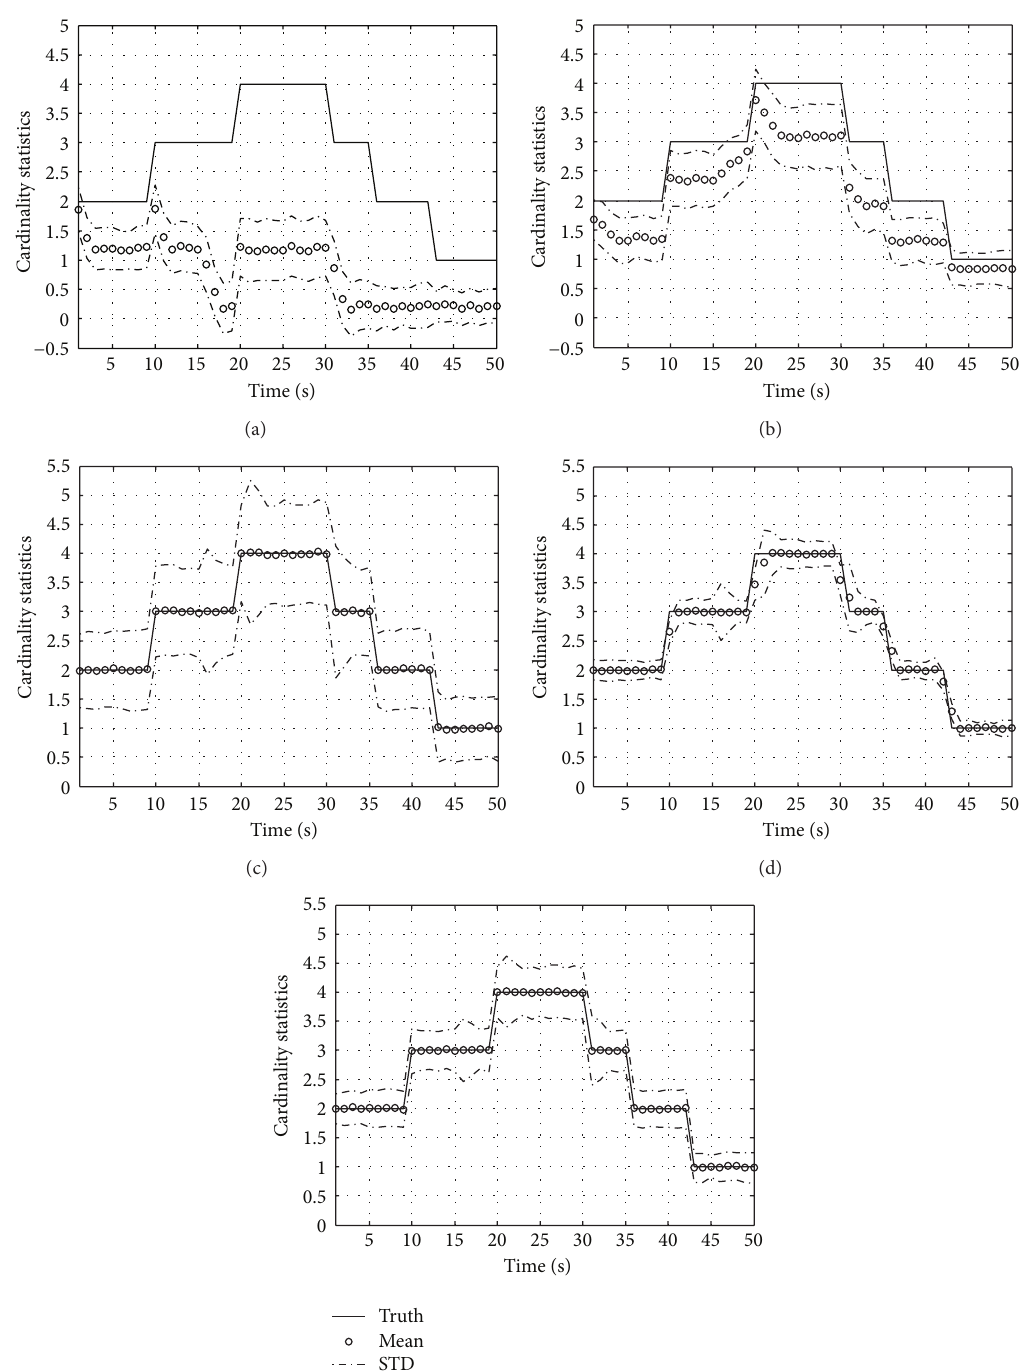
Figure 2: The 500 MC run averages of cardinality statistics versus time for the (a) CV model SMC-CBMeMBer filter, (b) CT model SMC- CBMeMBer filter, (c) SMC-MM-PHD filter, (d) SMC-MM-CPHD filter, and (e) SMC-MM-CBMeMBer